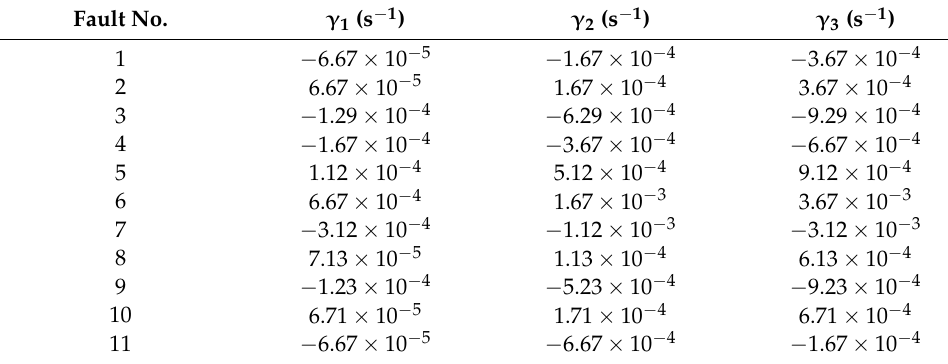
Table 5. Fault developing speeds in incipient